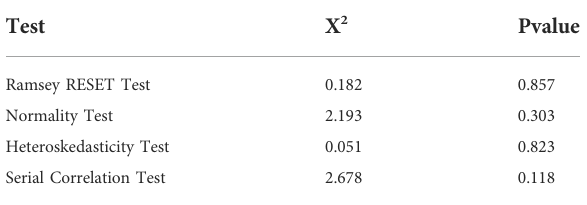
TABLE 7 Post estimation tests.